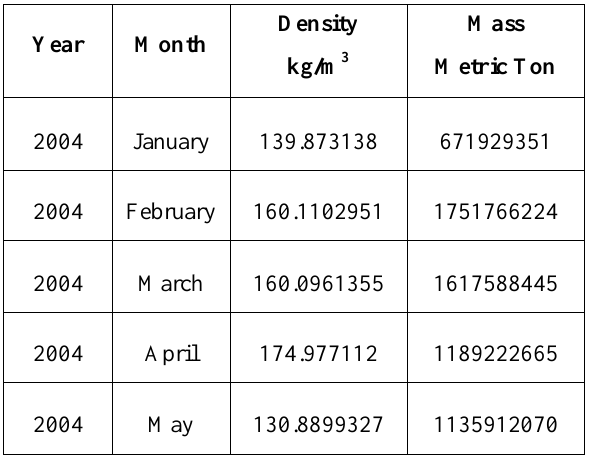
Table 4: Estimate of Water reserve from snow mass balance for year